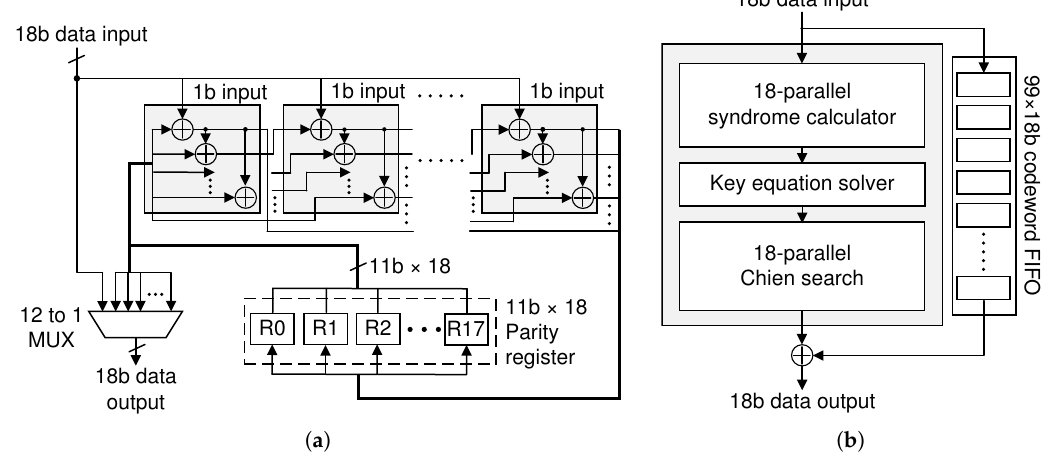
Figure 8. Block diagram of the proposed one-lane BCH encoder ( a ) and decoder ( b )